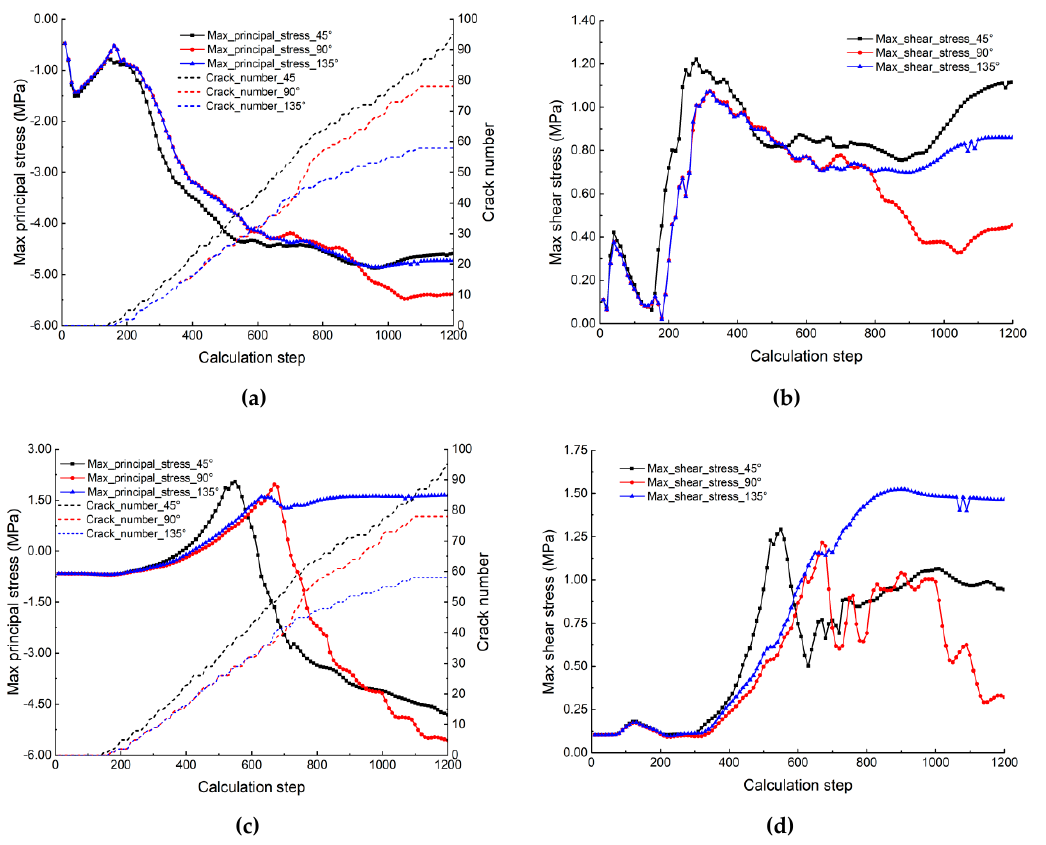
Figure 12. Principal stress curves of Group 2C under injection pressure of 8.70 MPa: ( a ) max principal stress history curve of Mc1; ( b ) max shear stress history curve of Mc1; ( c ) max principal stress history curve of Mc2; and ( d ) max shear stress history curve of Mc2.